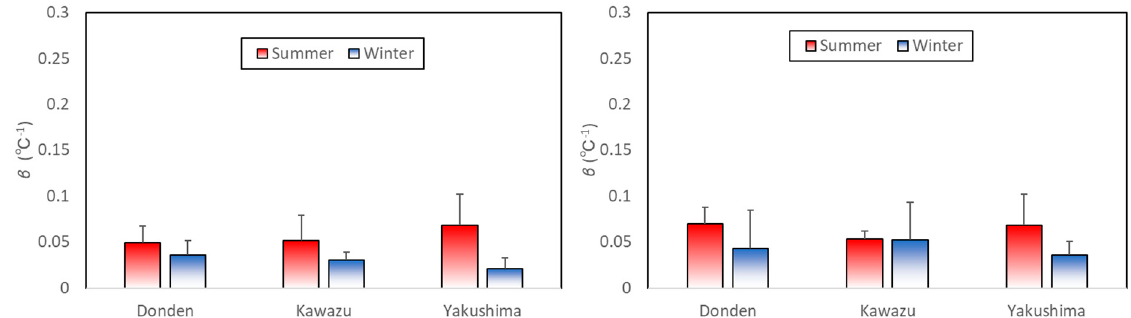
Figure 5. Comparison of the mean empirical coe ffi cient ( β ) for the control ( left ) and ozone exposure ( right ) groups between the summer and winter. Error bars indicate SD. No statistical significance was found.